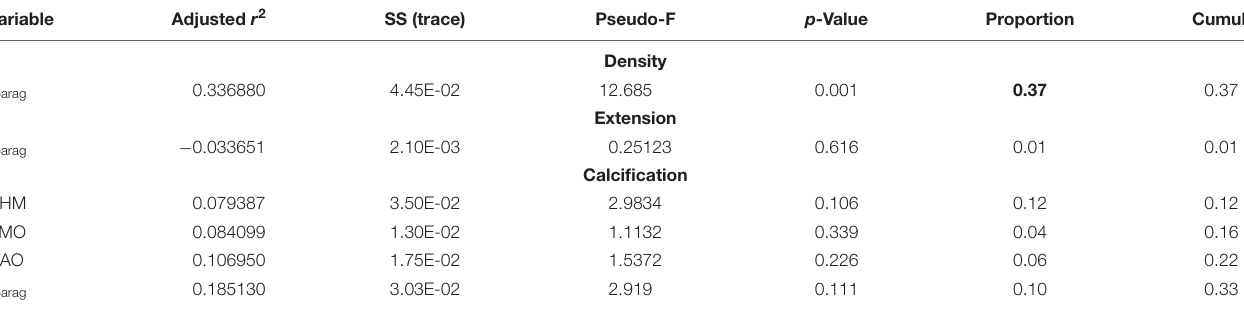
TABLE 5 | Results of sequential test for the period 1988–2011 performed by DISTLM forward analysis. Variable